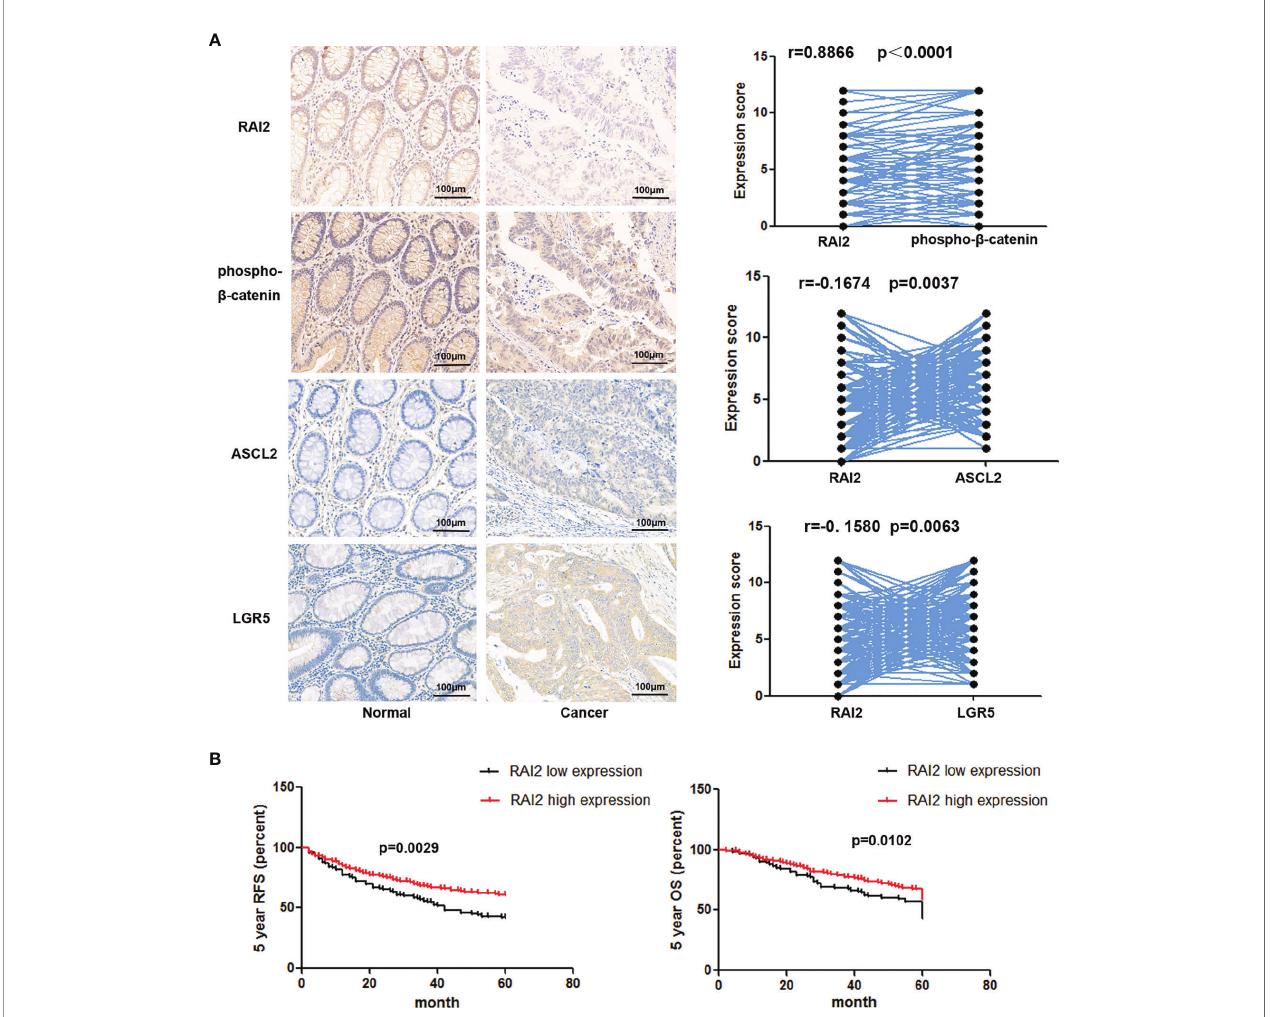
FIGURE 4 | Low expression of RAI2 was associated with a low level of phosphorylation of b -catenin and poor outcome in CRC. (A) Left panel: IHC staining of RAI2, phosphorylated b -catenin (p- b -catenin), ASCL2, and LGR5 in CRC tissues; right panel: the correlation between RAI2 expression and expression of p- b -catenin, ASCL2, and LGR5 (Spearman rank correlation test). (B) Kaplan-Meier curves show the association of the 5-year overall survival (OS) rate and relapse-free survival (RFS) rate of colorectal cancer patients with the expression status of RAI2. Black, RAI2-low expressed colorectal cancer patients (n = 101, log-rank test); red, RAI2- high expressed colorectal cancer patients (n = 197, log-rank